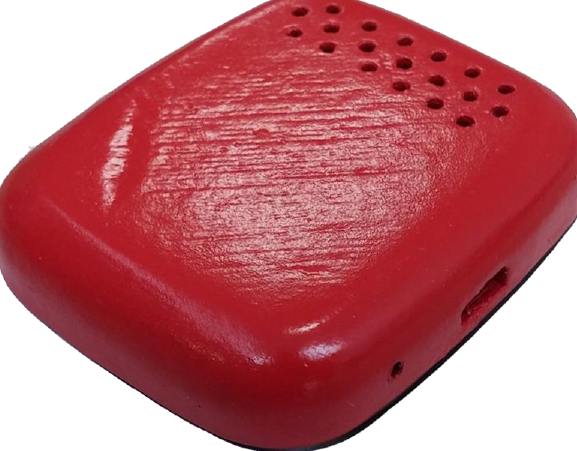
Figure 2. Special mounting unit designed for the sensing unit.